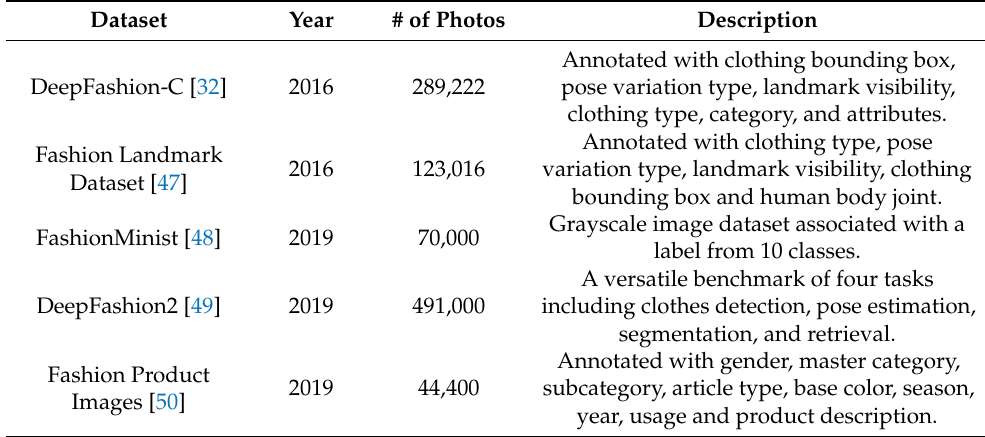
Table 2. Summary of available datasets for fashion category classification (adapted from [30]).